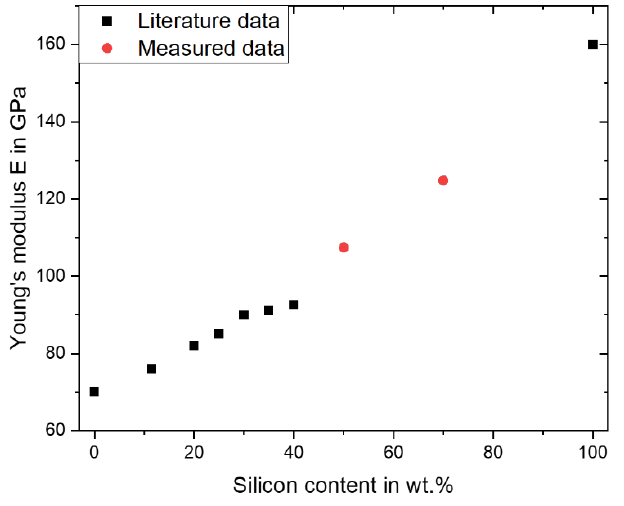
Figure 8. Literature data and measured data (AlSi50 p. and AlSi70 Al + Si from this work) for the Young’s modulus depending on the silicon content. The literature data was for pure aluminum and silicon [24], AlSi10Mg [11], AlSi20, AlSi25, AlSi30, AlSi35 all from [32] and AlSi40 [12].